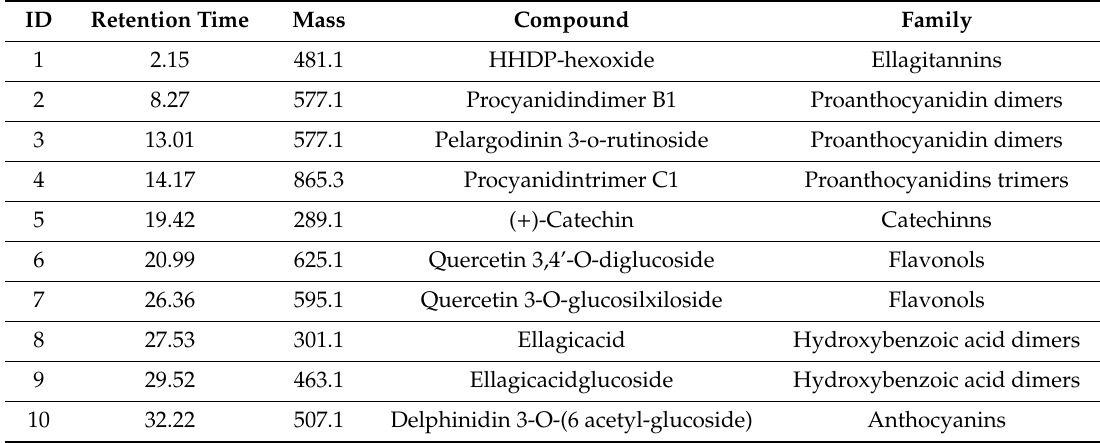
Table 4. Compounds present in Castilla Rose plant before solid-state fermentation.